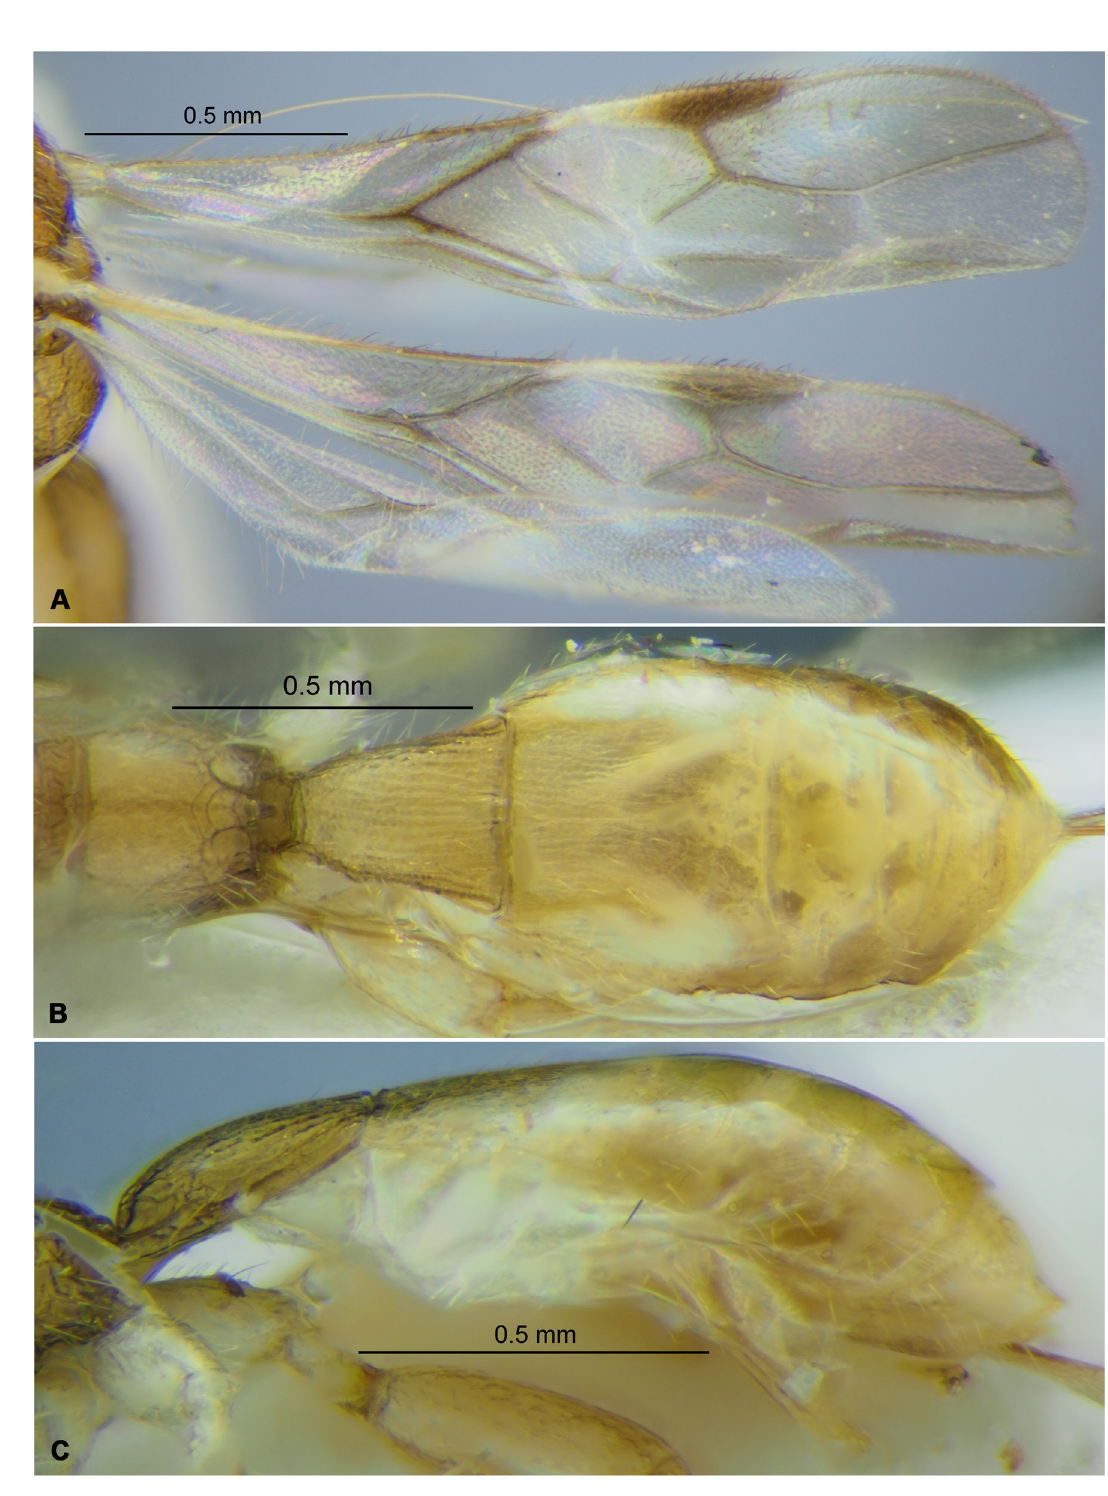
Fig. 6. Dendrosotinus ( Gildoria ) subelongatus Belokobylskij sp. nov., holotype, ♀ (RMNH). A . Wings. B . Propodeum and metasoma, dorsal view. C . Metasoma, lateral